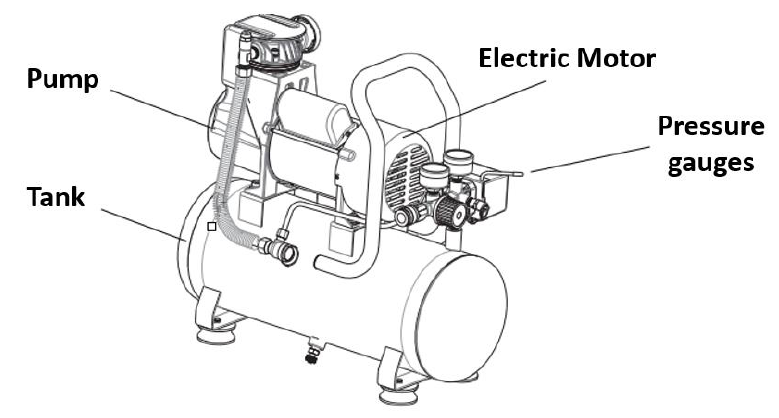
Figure 8. Major parts of the compressor [37].